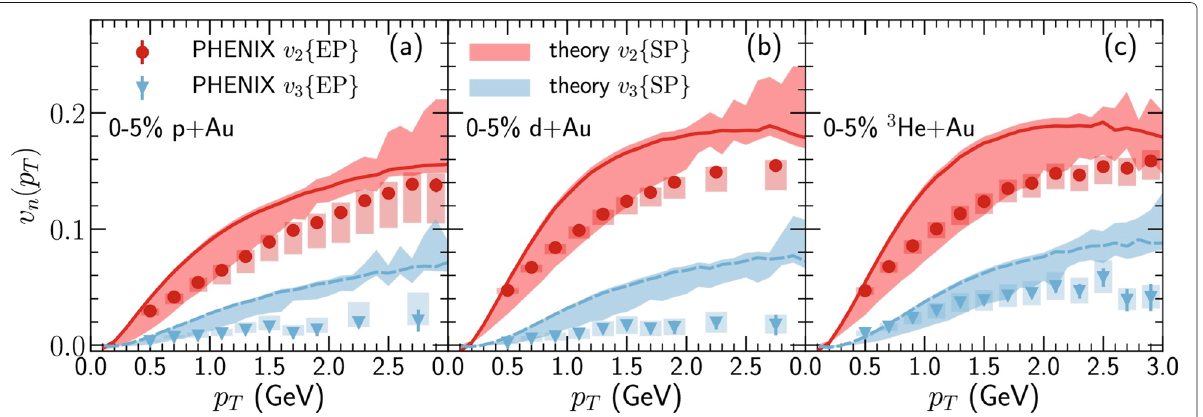
Fig. 14 Elliptic and triangular flow coefficients v n of charged hadrons as a function of the transverse momentum in p+Au, d+Au, and 3 He+Au √ collisions at s NN = 200 GeV from the PHENIX experiment [107]. Solid lines with bands represent calculations from viscous hydrodynamic models